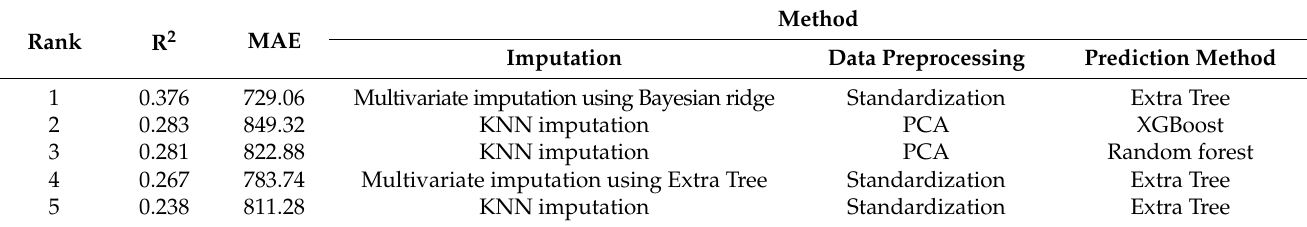
Table 4. Top 5 proposed results based on R 2 and MAE when missing data is imputed.